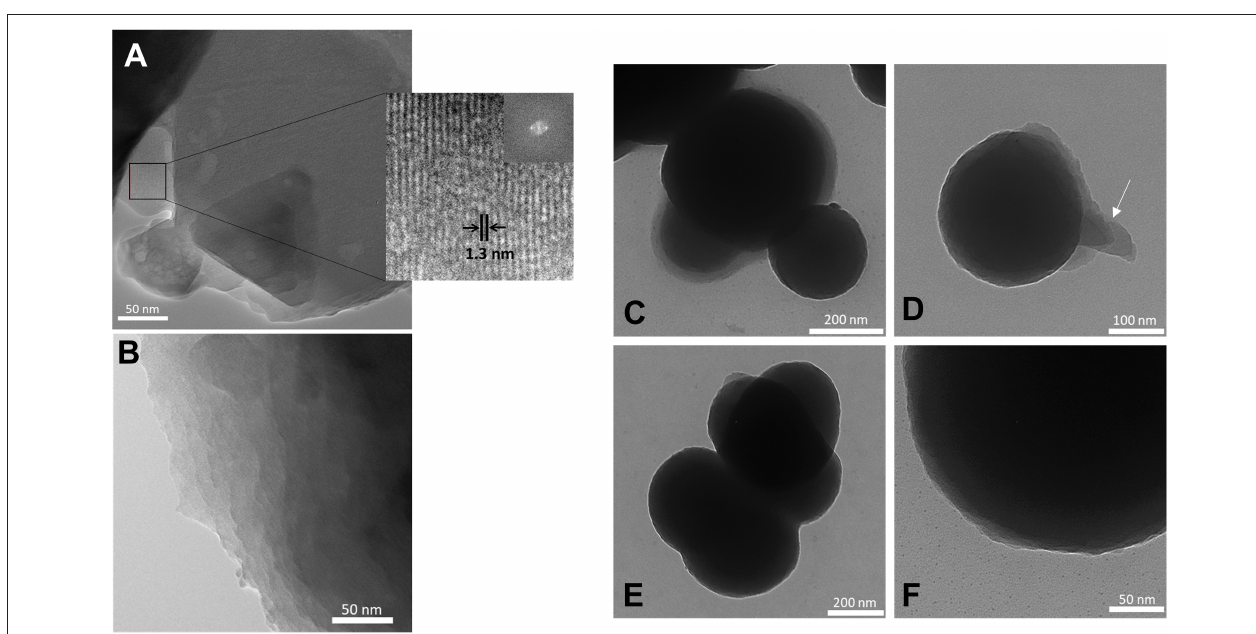
FIGURE 5 | TEM images of the BS-1 (A) , BS-2 (B) , BS-3 (C,D) , and BS-4 (E,F) hybrids.